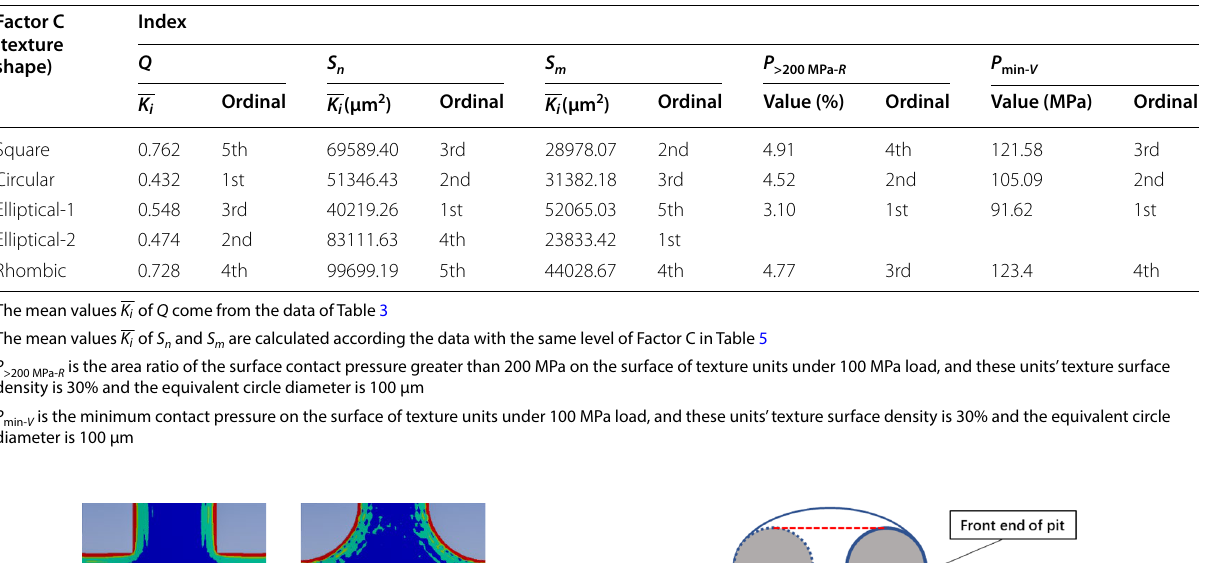
Table 6 Values and the ordinal number of indexes for the 5 levels of Factor C